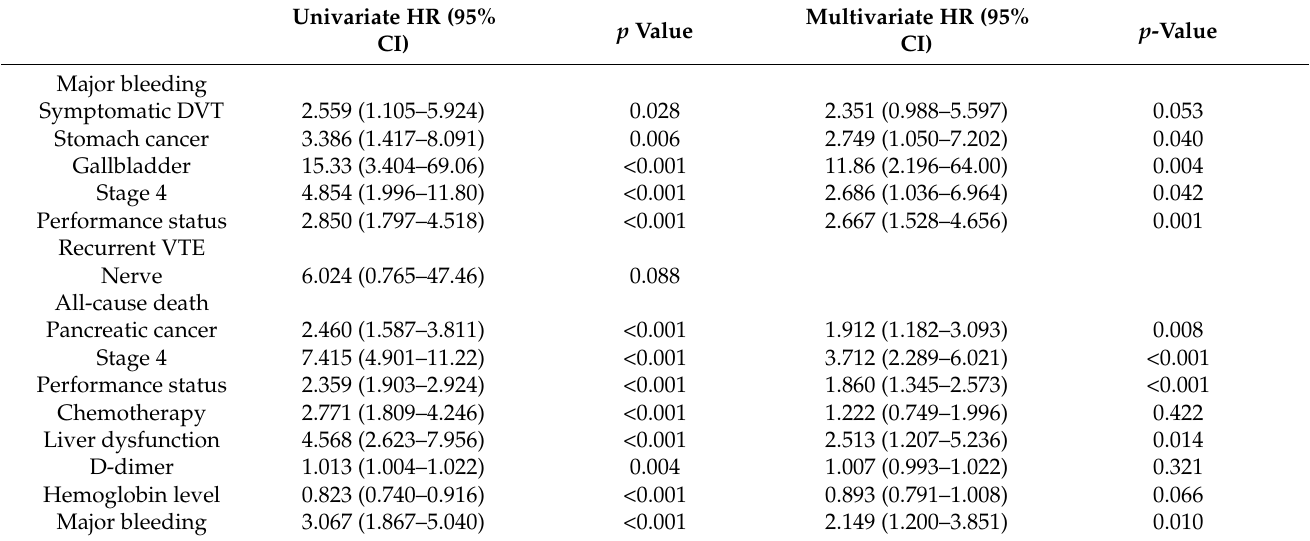
Table 5. Factors correlated with major bleeding, recurrent VTE, and all-cause death. Univariate HR (95%